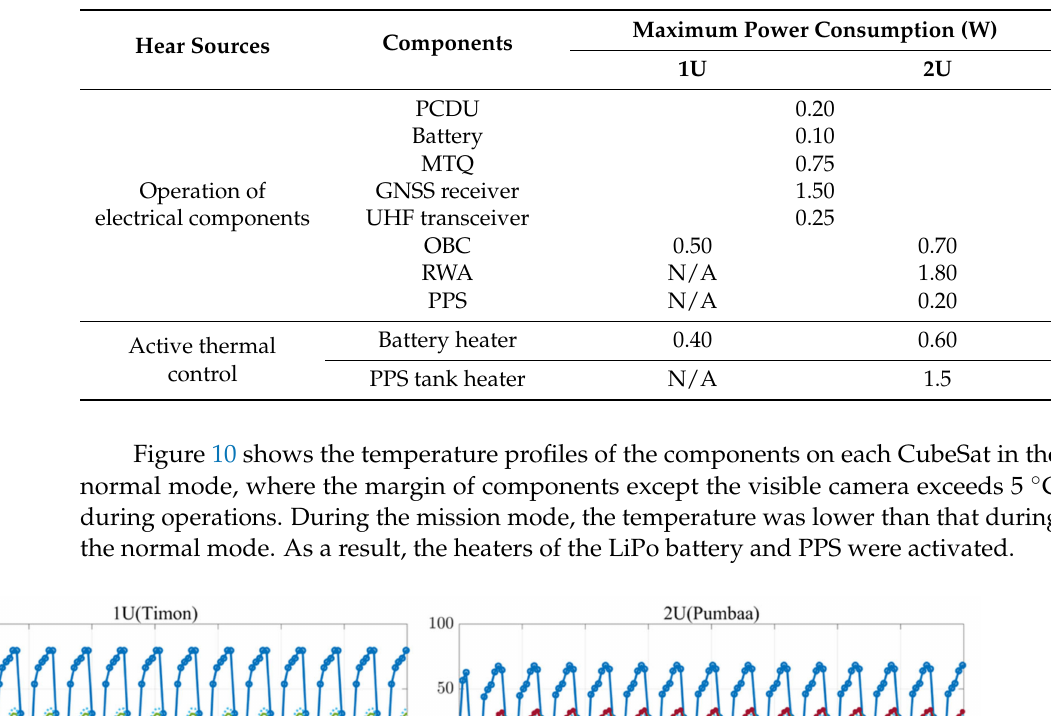
Table 5. Power consumption of electrical components and active